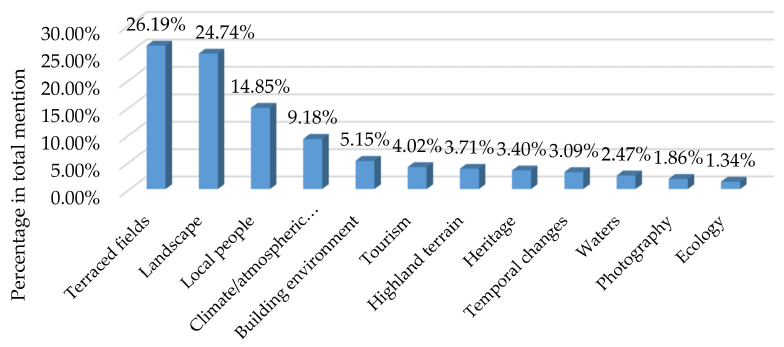
Figure 4. Themes in tourists’ comments about Honghe on Mafengwo.com